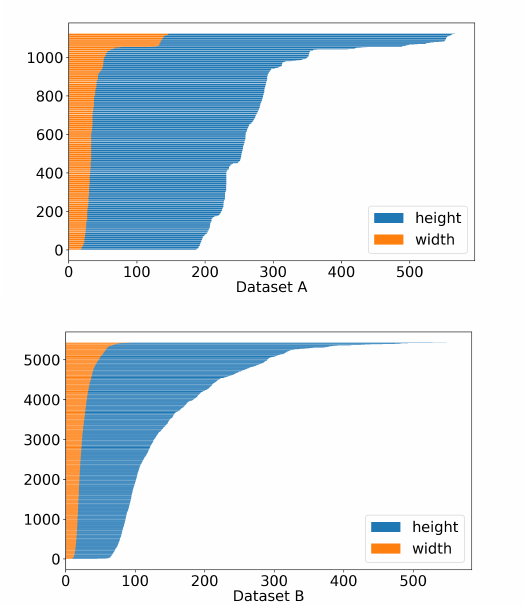
Figure 4. The distributions of the ship length and width on Dataset A and Dataset B, respectively. The horizontal axises represent the length and the height of the ships and the vertical axises represent the number of ship instances.